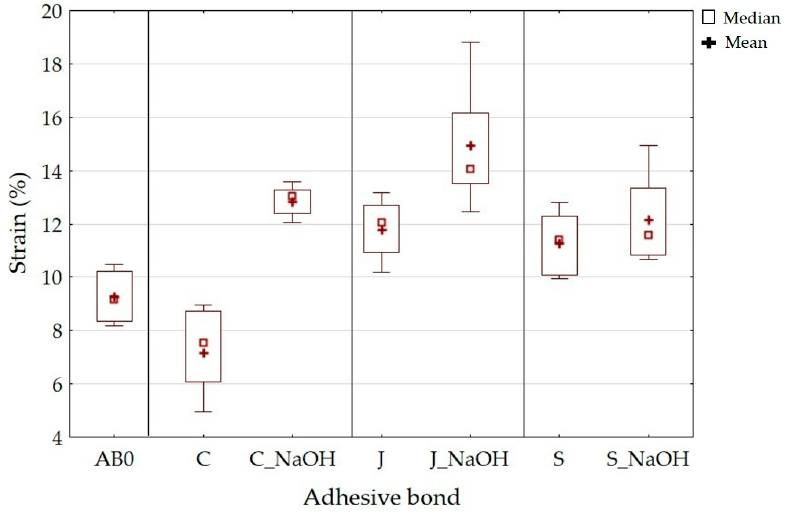
Figure 7. Static tensile test—strain.